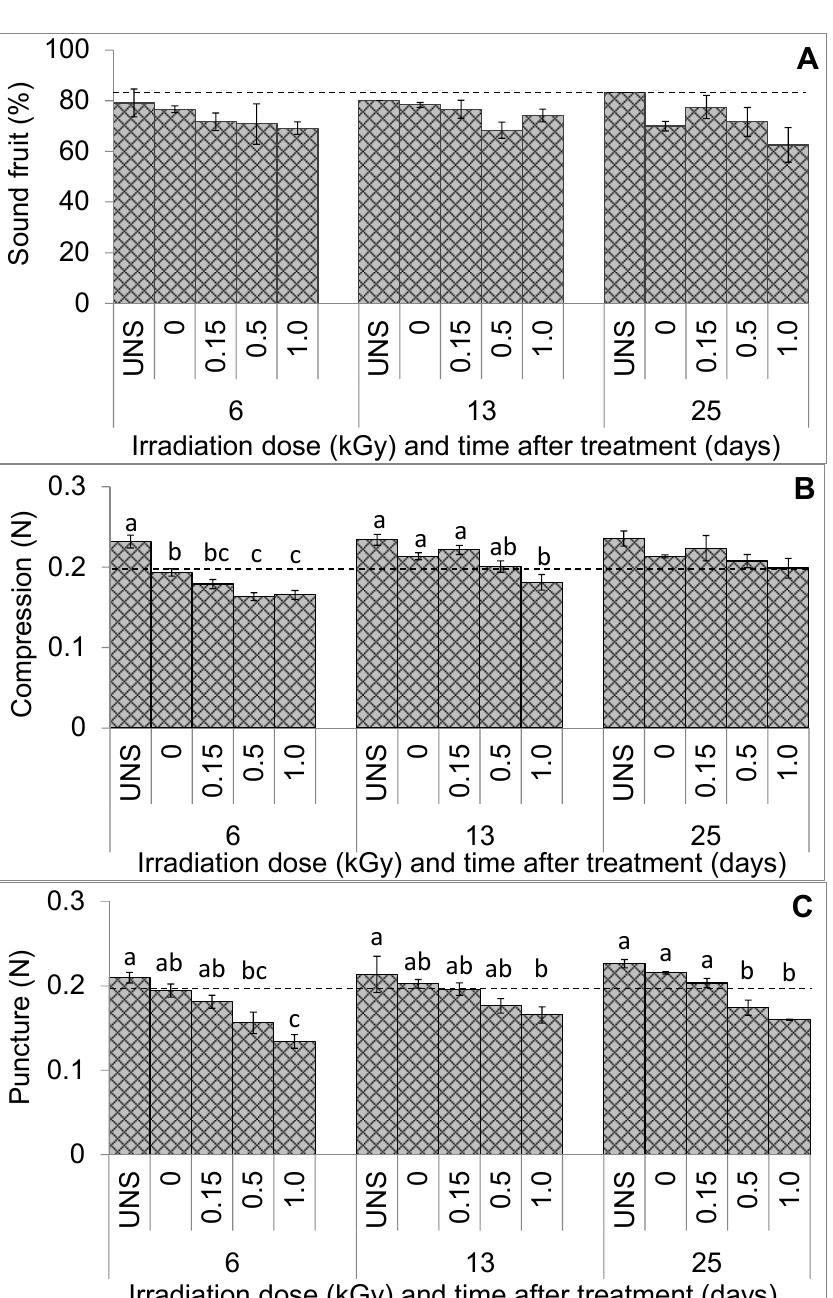
Figure 1. Effect of Electronic Cold-Pasteurization TM on percent sound fruit ( A ), compression ( B ), and puncture ( C ) for ‘Farthing’ blueberries in trial 1. Treatments included an unshipped control (UNS; not shipped to the irradiation facility) and four levels of irradiation; no irradiation control (0), 0.15, 0.5, and 1.0 kGy. Evaluations were conducted 6, 13, and 25 days after irradiation treatment. Fruit were stored at 2 to 4 °C under high relative humidity until assessments were performed. An initial fruit quality assessment was performed after harvest shown as a horizontal dashed line. Means within the same storage times after treatment followed by the same letter are not significantly different from each other based on one-way analysis of variance ( α =